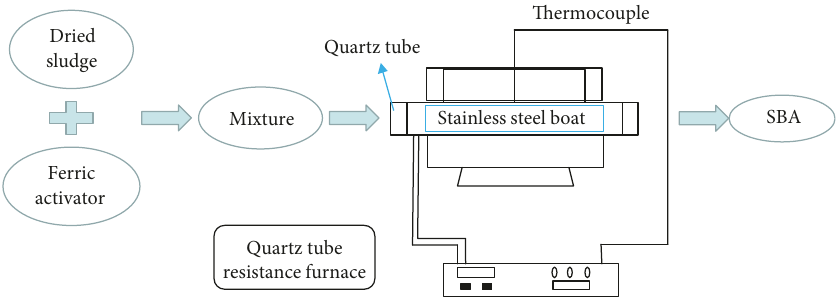
Figure 5: The preparation of SBAC using activated iron [54]. Table 1: Surface physicochemical characteristics of SBAC generated with pretreatment by di ff erent substances. Substance